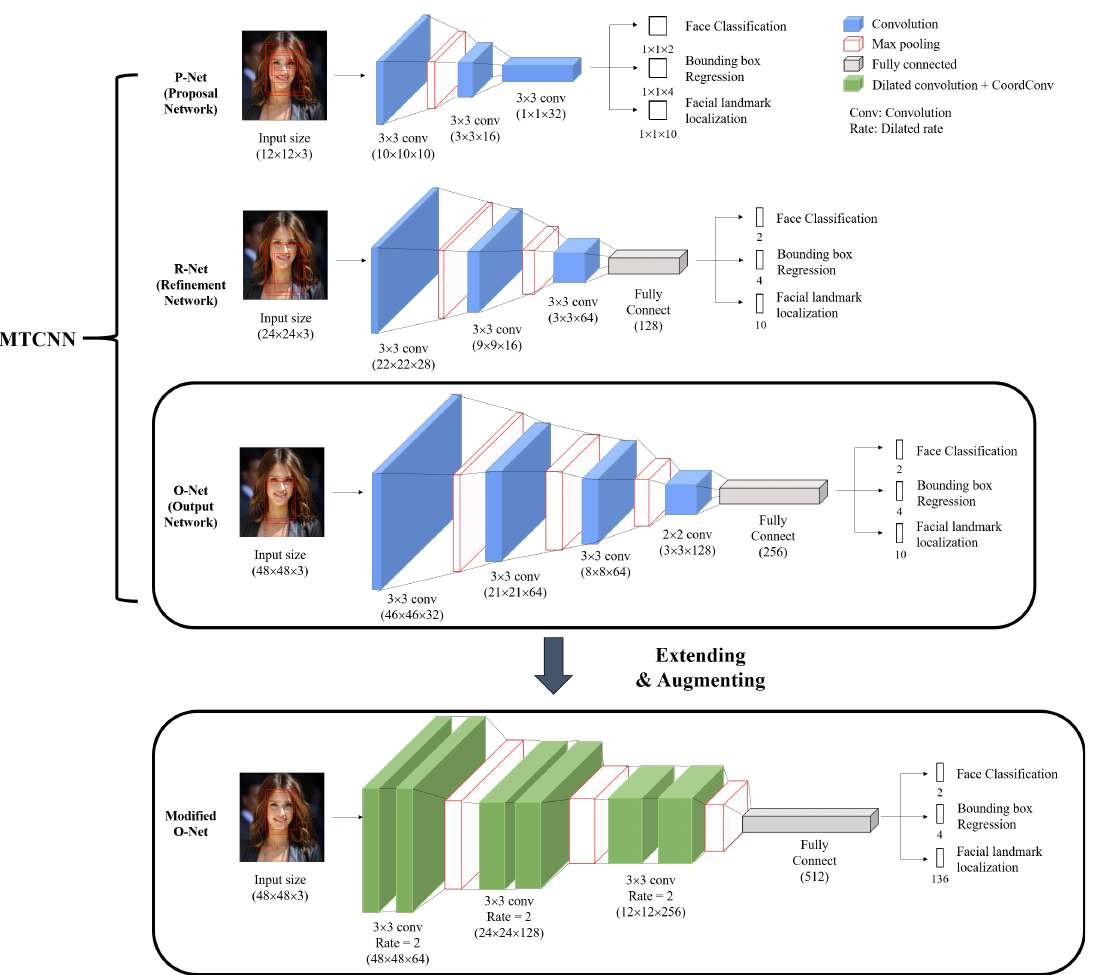
Figure 1. Augmented EMTCNN with modified